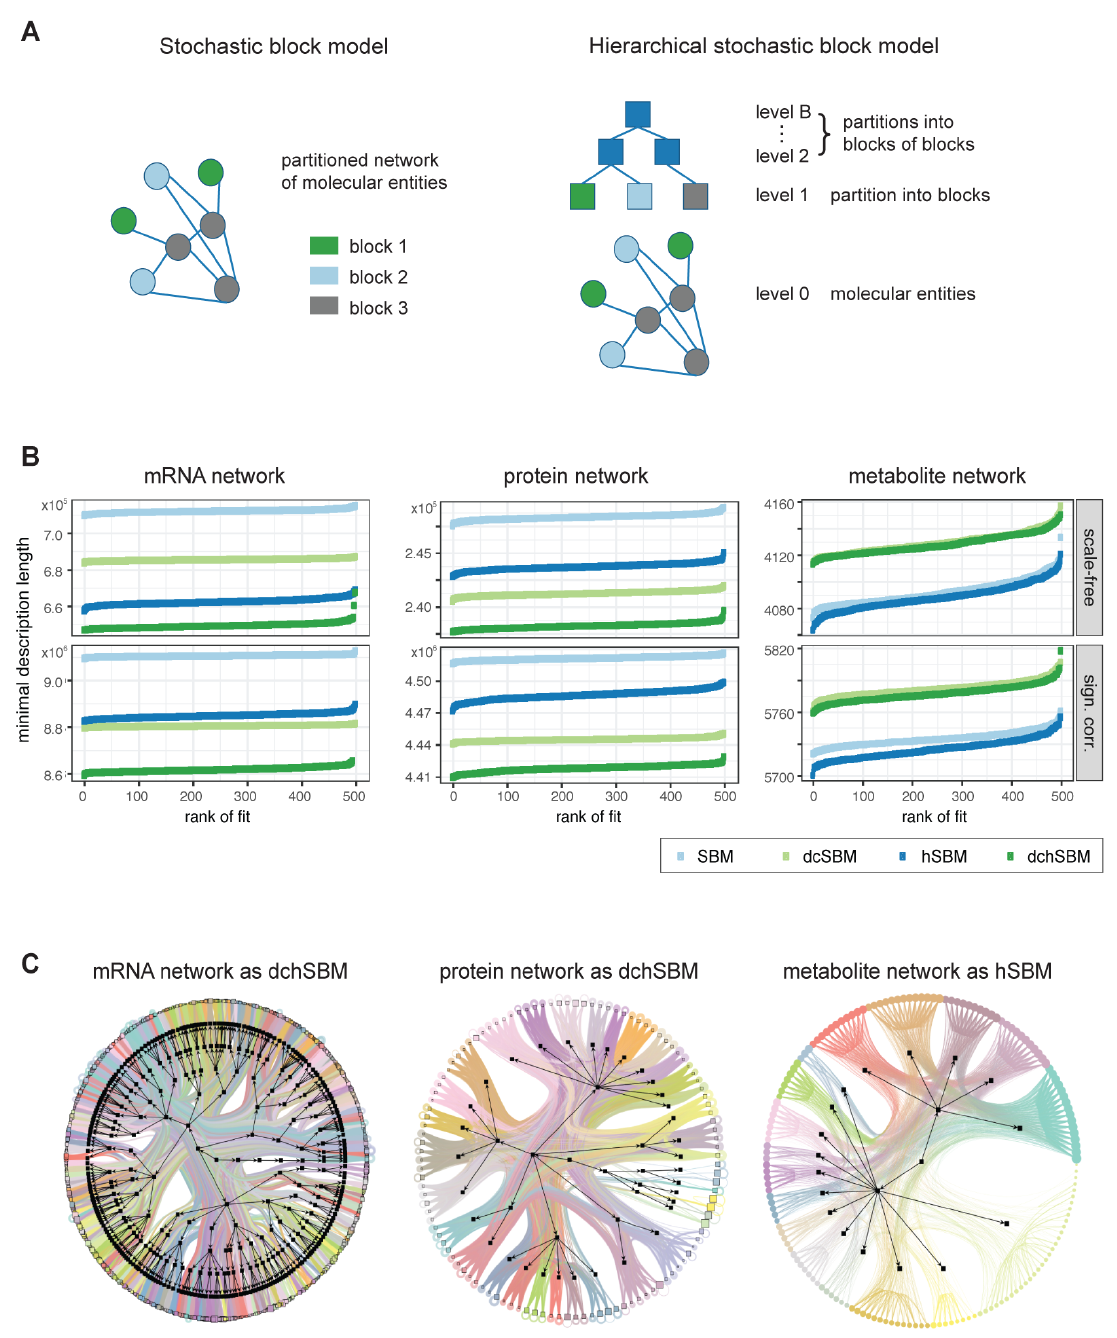
Figure 2. Stochastic block models for representing correlation-based biomolecular networks. ( A ) In a stochastic block model (SBM) representation, the nodes of a network are partitioned into blocks according to their similarity in connectivity. The hierarchical version of the SBM (right) imposes in addition hierarchical partitions onto the blocks. ( B ) Six biomolecular networks derived from transcriptomic, proteomic or metabolomics data of breast tumours were fitted to four different types of SBM: the classical SBM (SBM, light blue), the degree-corrected SBM (dcSBM, light green), the hierarchical SBM (hSBM, dark blue) and the degree-corrected hierarchical SBM (dchSBM, dark green). We performed fits for 500 initial partitions for each network. A fit consists of altering the partitions underlying the SBM such as to minimize the description length. The smaller the description length the better the fit. Hierarchical SBMs outperform non-hierarchical SBMs, degree correction is required for the mRNA and protein networks. ( C ) Graphical representations of the best fitting hierarchical stochastic block models with degree correction (dchSBM) or without (hSBM) for the networks reduced by significance of correlation (mRNAs, metabolites) or by scale- freeness (protein). The lowest layer (genes, proteins) is truncated in the mRNA and protein networks, colored lines denote edges between blocks of the first level (for mRNA, protein network) or between metabolites (level 0, metabolite network). Edges of blocks or metabolites which belong to the same block in the level above have the same colour. The higher-order hierarchical structure is shown in black. Page 11